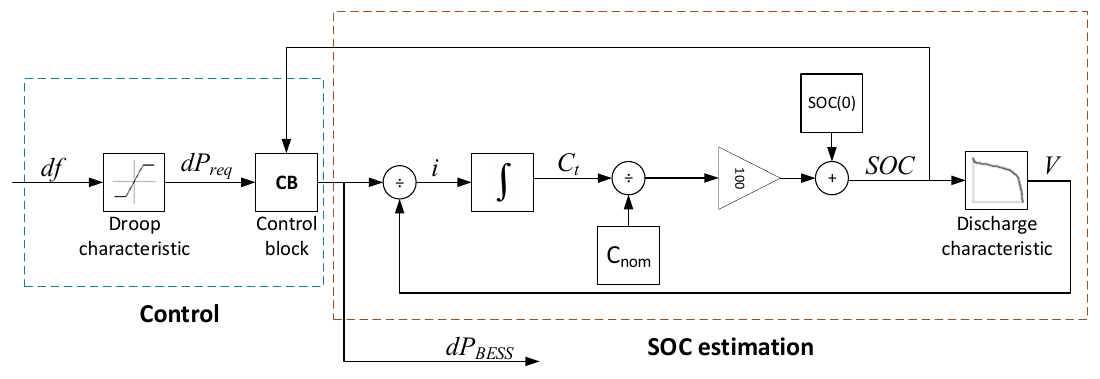
Figure 3. Block diagram of BESS performance model.